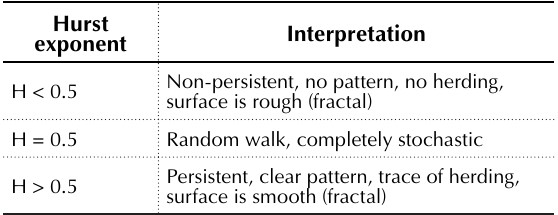
Table 3. Zones of Hurst exponent